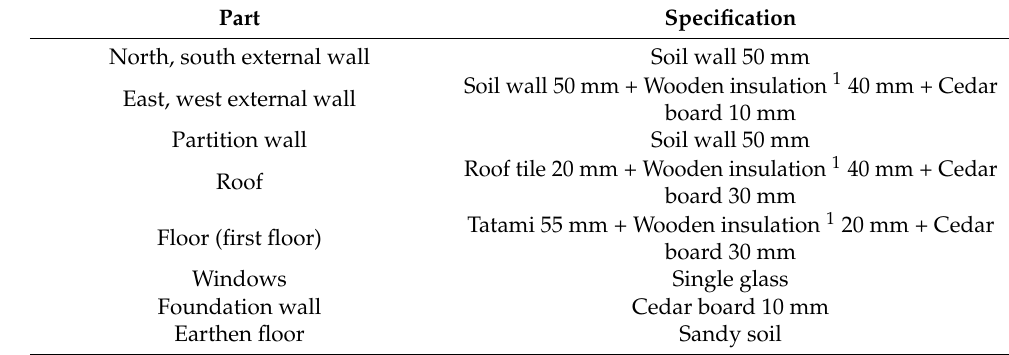
Table 2. Specifications of the building envelope.